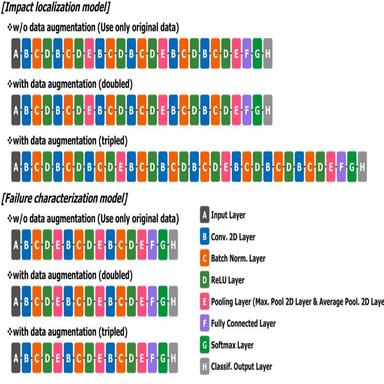
Details of optimized convolution neural network architecture.